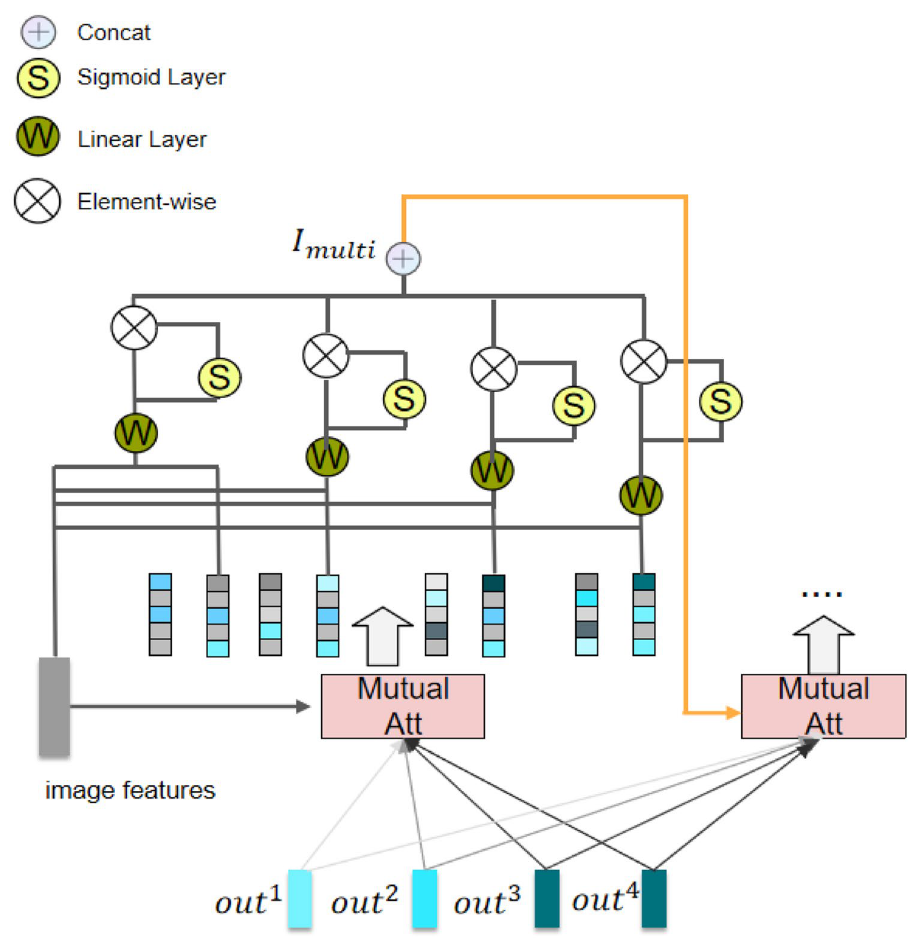
obtain the image features I mutual after interacting with the question features Out . Add & Norm ( forward layer are nested again.